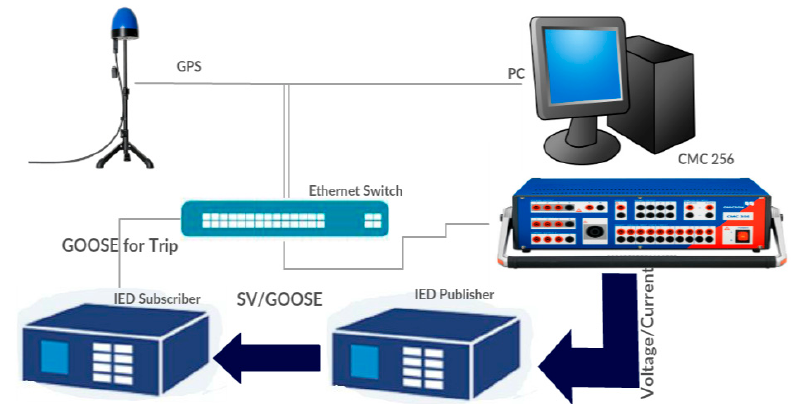
Figure 3. The full scheme of testing the IEC 61850 (SMV-GOOSE). Table 1. GPS data sheet and timing protocols.